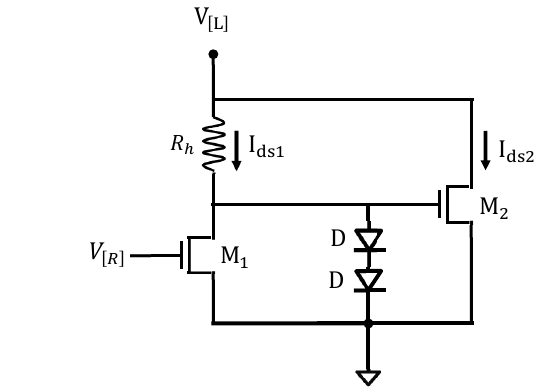
Fig. 2: Analog MOS Transistor Circuit Model for Hill Process, where n is represented by channel length of Transistor M (cid:28) .